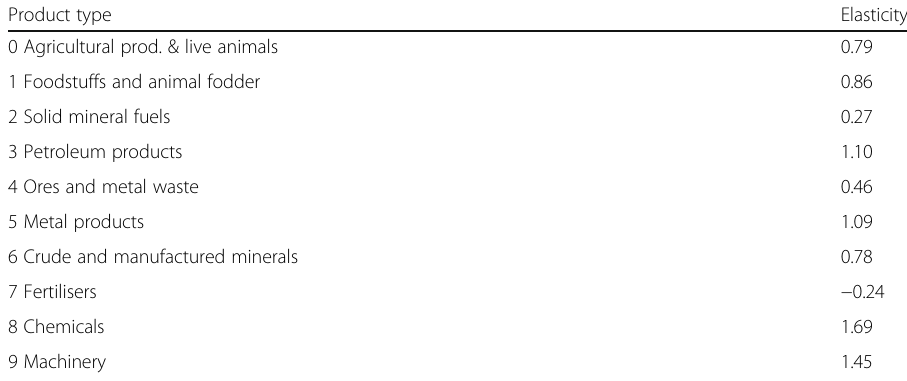
Table 2 Elasticity of trade flow in tonnes in random effects model if the GDP increases (by 1%) and population remains constant Product type